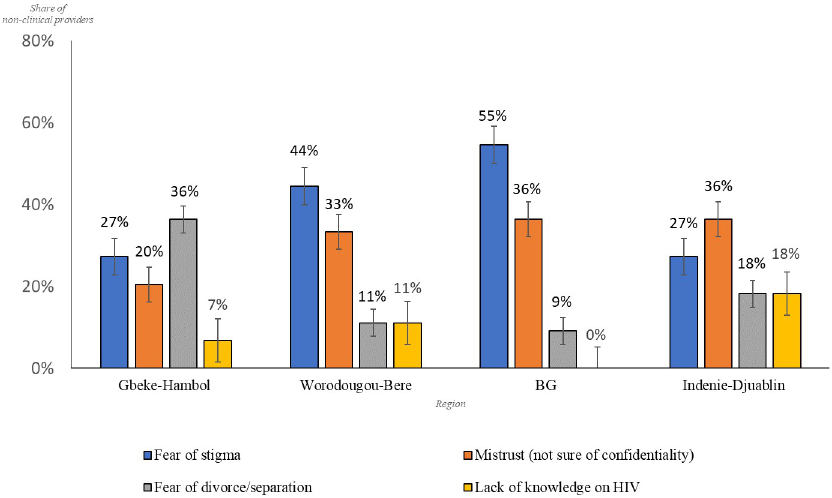
Fig 3. What challenges have you encountered with obtaining the names of family and sexual partners? Challenges faced when obtaining the names of family and sexual